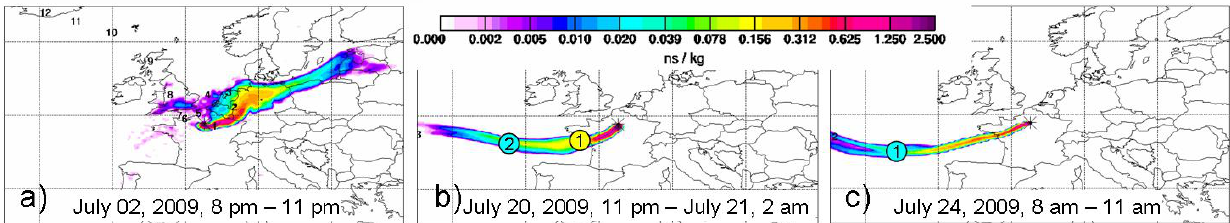
Fig. 3. Examples for (a) “Central Europe”, (b) “Atlantic Polluted”, and (c) “Atlantic Clean” air masses distinguished using FLEXPART footprint emission sensitivities . The numbers in circles denote the approximate location of the centroid of the air mass at the respective number of days prior to